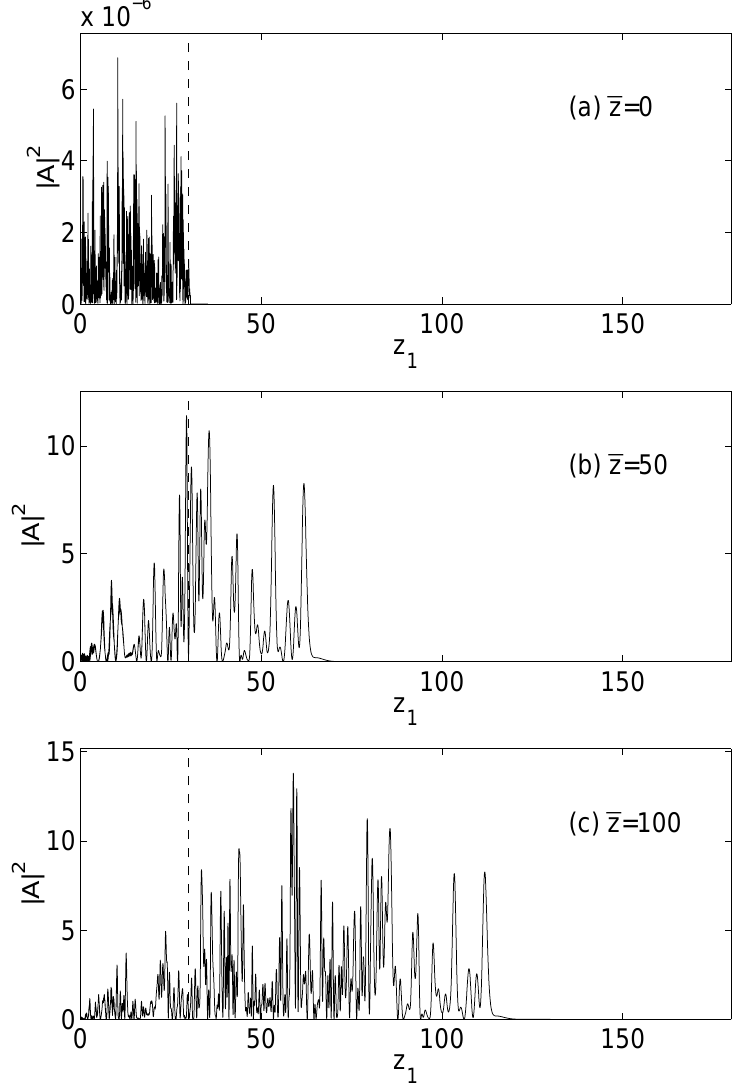
Figure 9. SASE mode operation: typical temporal pattern of the intensity | A r | 2 vs. z 1 for a long beam with l b = 50 l c , at different undulator lengths ¯ z : ( a ) ¯ z = 0; ( b ) ¯ z = 50; ( c ) ¯ z =